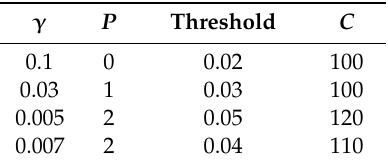
Table 2. The SVM algorithm option tested to classify